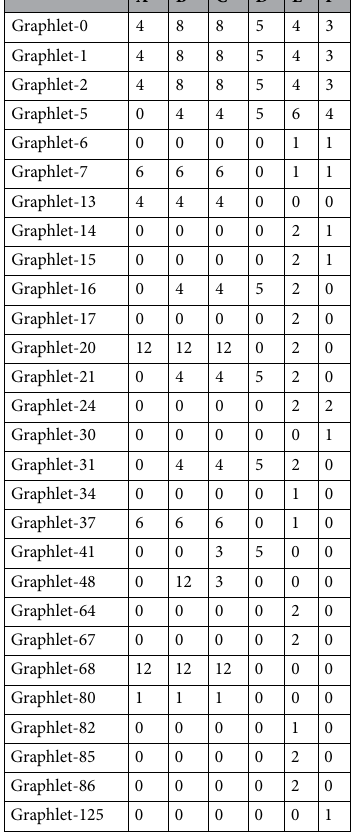
Table 3. Distribution of pn-graphlets in structures A–F from Fig. 13.